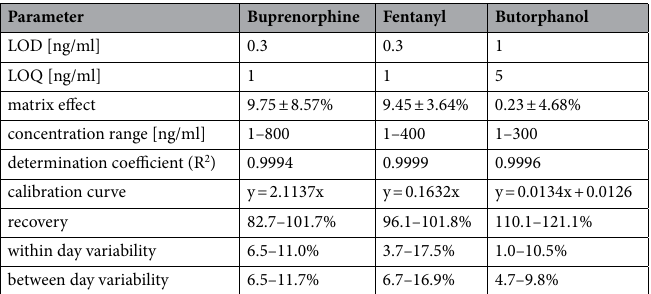
Table 2. Validation parameters obtained for three opioids in cell lysates. LOD—limit of detection, LOQ— limit of quantification. The results were obtained from 9 validation curves, except for the within day variability where 3 curves were considered.